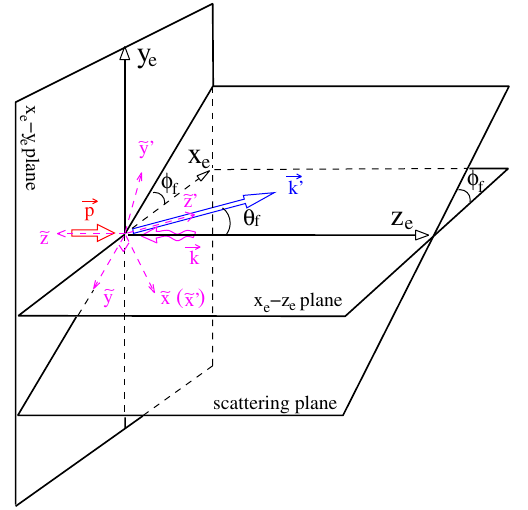
FIG. 3. Coordinate systems of Compton scattering of an elec- Þ is the ; y ; z tron and a photon in a laboratory frame. ð x e e e coordinate system for the incident electron ( ~p ) moving along -axis direction. For the head-on collision, the incident the z e axis, and the scattered photon ( ~k ) comes along the negative z e photon ( ~k 0 ) is moving along the direction given by the polar and azimuthal angle (cid:3) . The momentum vectors ~k and angle (cid:2) f f ~k 0 form the scattering plane. ð ~ x; ~ y; ~ z Þ is a right-hand coordinate system attached to the scattering plane. The ~ z axis is along the direction of ~k ; the ~ x axis is perpendicular to the scatter plane; and the ~ y axis is in the scattering plane. ð ~ x 0 ; ~ y 0 ; ~ z 0 Þ is another right- hand coordinate system attached to the scattering plane. The ~ z 0 axis is along the direction of ~k 0 ; the ~ x 0 axis is the same as the ~ x axis; and the ~ y 0 axis lies in the scattering